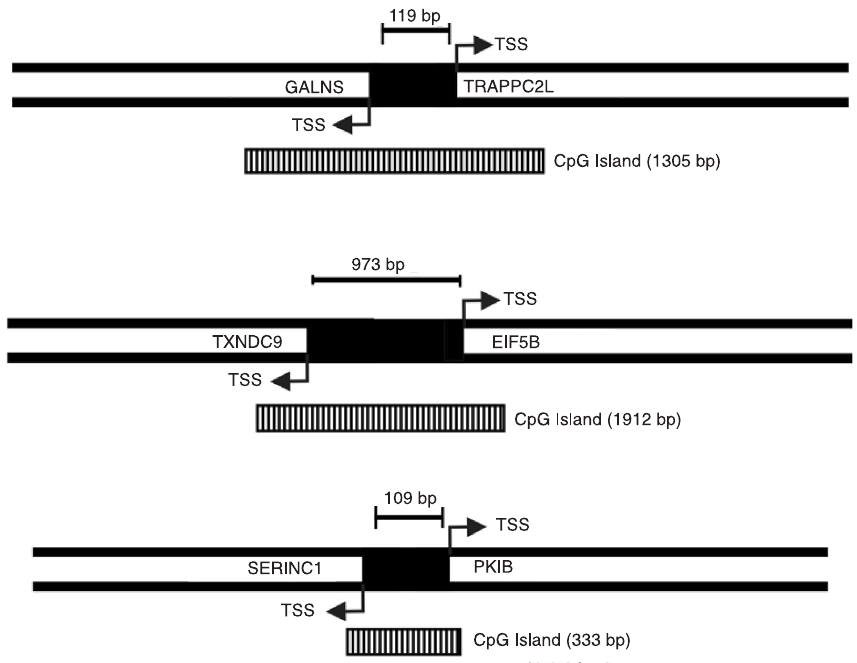
Figure 2. Schematic presentation of the bidirectional gene pairs GALNS/TRAPPC2L , TXNDC9/ EIF5B , and SERINC1/PKIB . The transcriptional units of the bidirectional gene pairs are organized in a head-to-head orientation on chromosomes 16q24.3 ( GALNS/TRAPPC2L ), 2q11.2 ( TXNDC9/ EIF5B ), and 16q24.3 ( SERINC1/PKIB ) (http://genome.uscs.edu). The transcript start site (TSS) for each gene is indicated by black arrows, which show the transcriptional direction. Open boxes indicate the first exons of each gene. Black boxes indicate intergenic sequences for each gene pair. The boxes with vertical bars represent CpG-rich